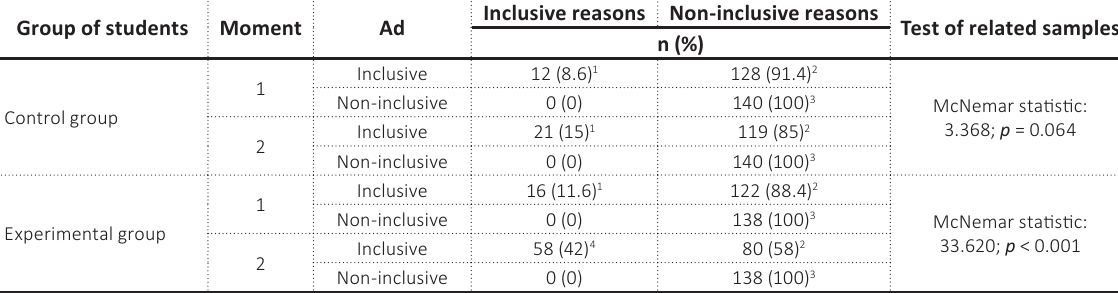
Table 2. Questionnaire trial 2: Results of what the students like more in both ads Group of